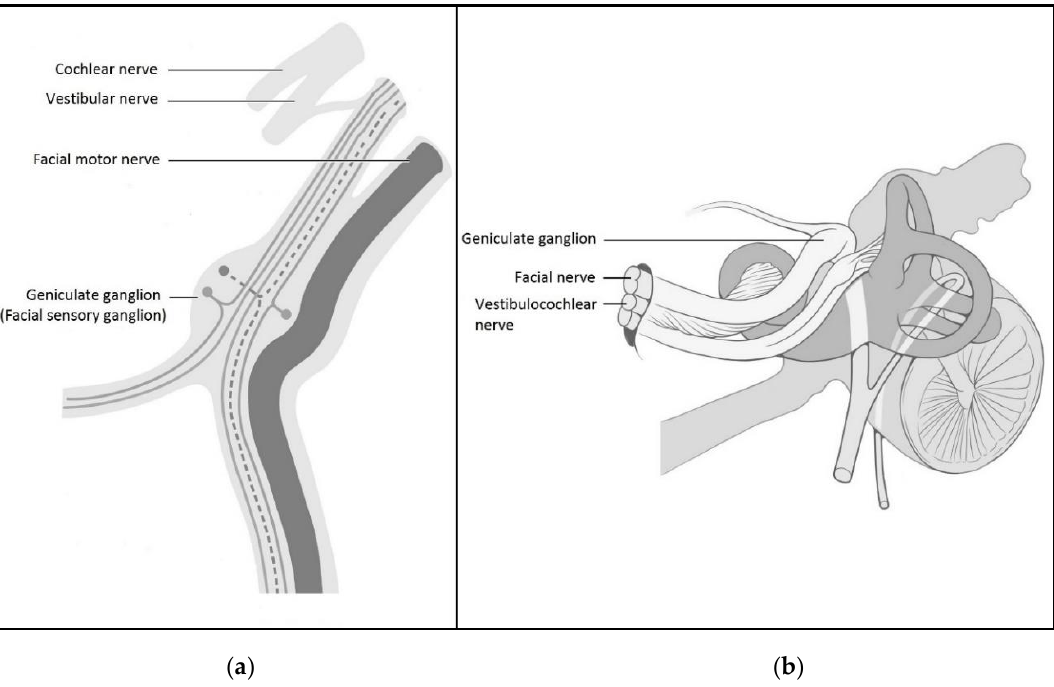
Figure 2. ( a ) A close relationship of the geniculate ganglion to the facial motor nerve. Modified from Duu’s Topical Diagnosis in Neurology 2005, 4th edition, permitted by Thieme Medical Publishers; ( b ) A close relationship of the geniculate ganglion to the vestibulocochlear nerve. Modified from the Creativecommons.org.